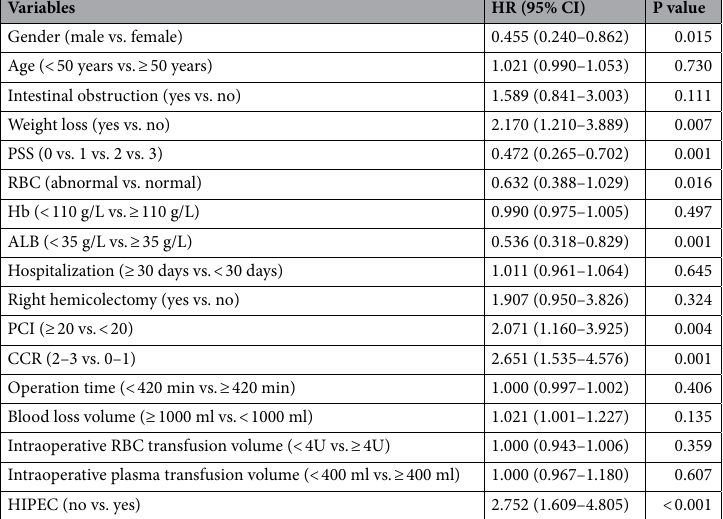
Table 2. Univariate analysis of OS after CRS (n = 165). OS overall survival, CRS cytoreductive surgery, HR hazard ratio, CI confidence interval, PSS prior surgical score, RBC red blood cell, Hb hemoglobin, ALB Albumin, PCI peritoneal cancer index, CCR completeness of cytoreduction, HIPEC hyperthermic intraperitoneal